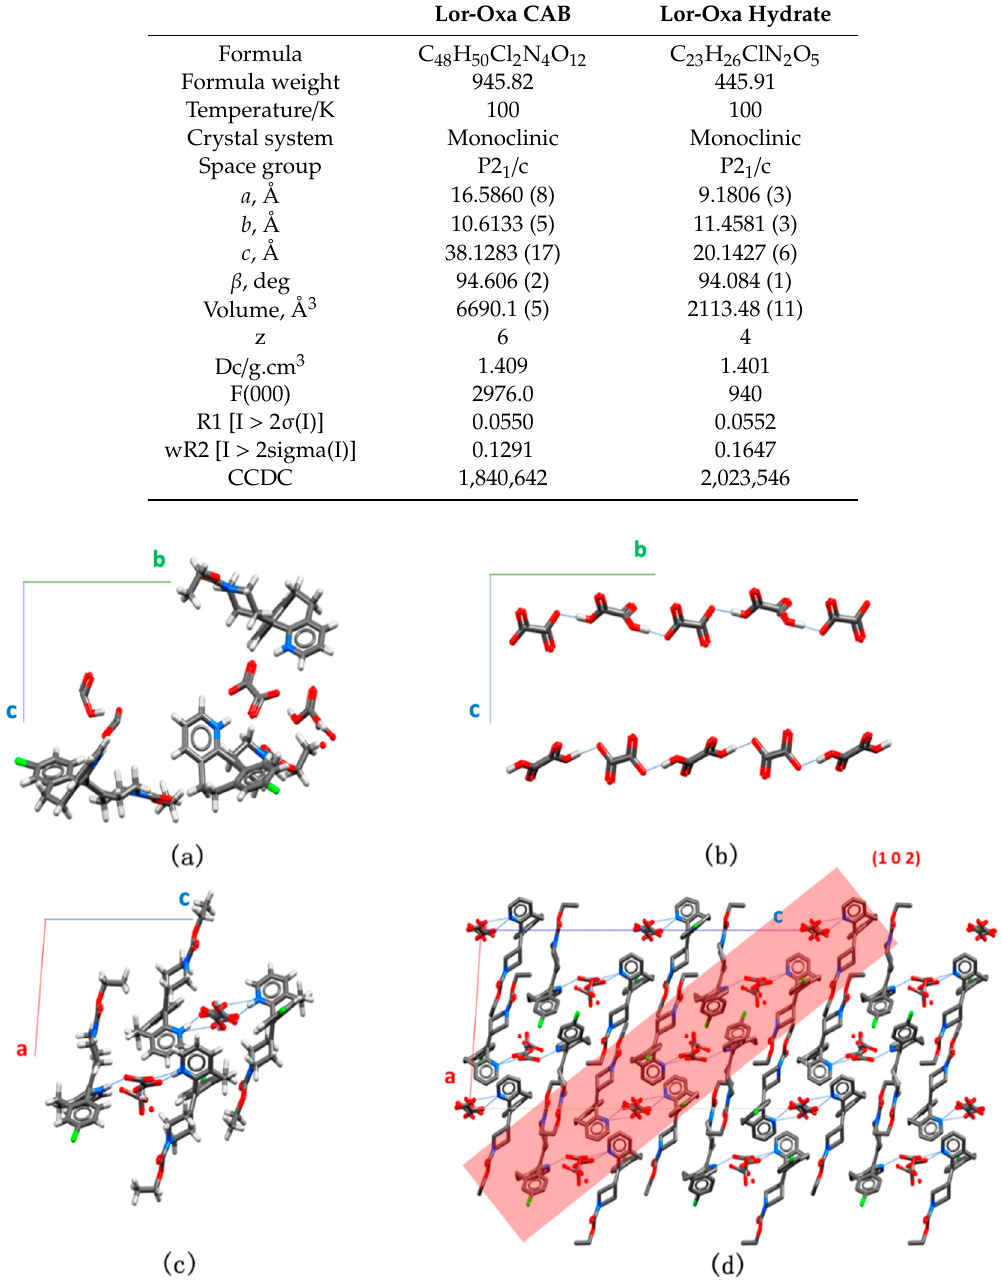
Table 1. Crystallographic data for Lor-Oxa CAB and Lor-Oxa hydrate.